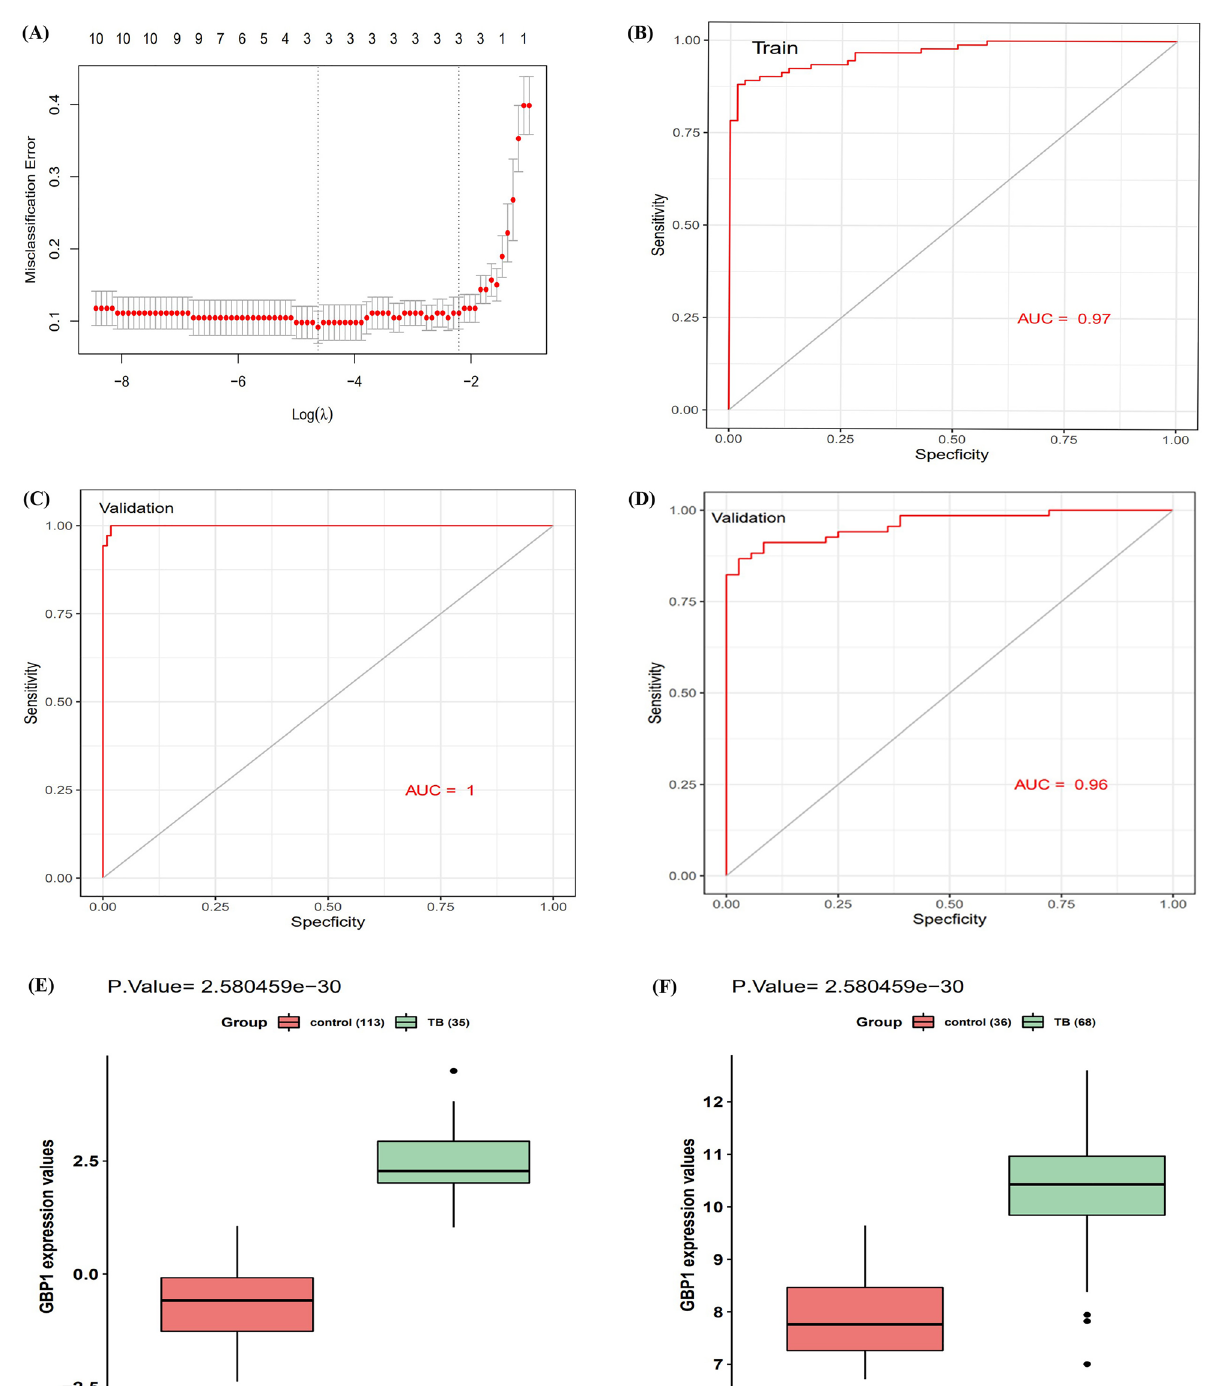
Figure 4. A model for predicting TB and verification of expression of GBP1 in differential datasets. ( A ) LASSO model. ( B ) ROC curves analysis of train set (GSE83456). ( C ) ROC curves analysis of validation (GSE42834). ( D ) ROC curves analysis of validation (GSE19491). ( E ) GBP1 is up-regulated in TB (P = 2.580e-30, 35 TB patients and 113 normal samples are contained). ( F ) GBP1 is up-regulated in TB ( P = 2.580e-30, 68 TB patients and 36 normal samples are